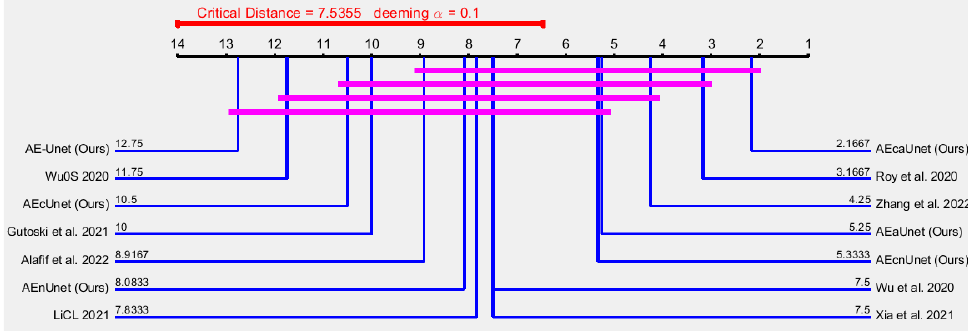
Figure 22. Nemenyi [141] post hoc critical distance diagram for α = 0.10 using fAUC numerics in Table 11 for G 6